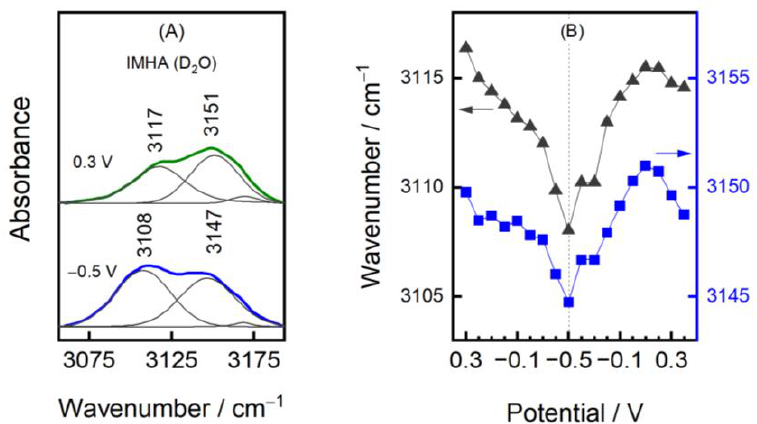
Figure 8. Analysis of the ring C–H stretching modes at 3115 and 3150 cm − 1 . ( A ) SEIRAS spectra of IMHA SAM in D 2 O at 0.3 and –0.5 V potentials in the 3056–3193 cm − 1 range (colored lines). The experimental spectra are fitted with Gaussian-Lorentzian shape components (grey lines). ( B ) The dependency of 3115 (black triangles) and 3150 cm − 1 (blue squares) wavenumbers on the electric po- tential.